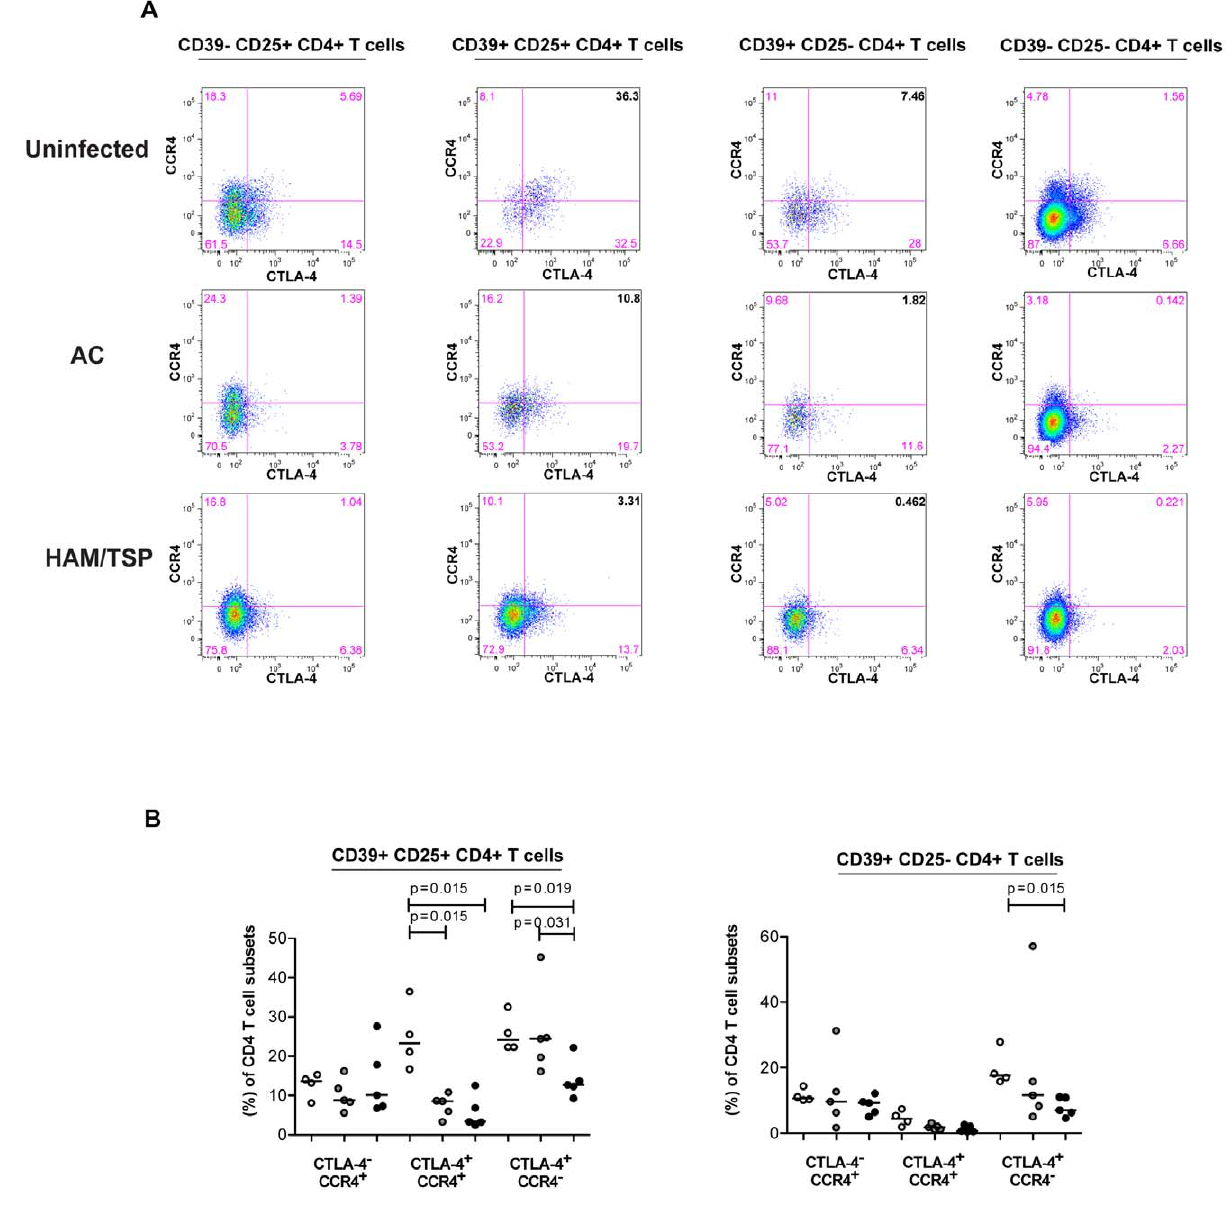
Figure 2. Expression of CTLA-4 and CCR4 in CD4 + T-cell subsets based on CD39 and CD25 expression. The statistical difference was deemed significant using a Mann-Whitney U test analysis if p , 0.05. Horizontal bars denote median values. (A) CTLA-4 and CCR4 expression on CD4 + T cells from one representative uninfected donor, one HTLV-1-infected-asymptomatic carrier and one HAM/TSP patient. (B) Proportion of expression of CTLA-4 and CCR4 in CD39 + CD25 + and CD39 + CD25 2 CD4 + T cells of uninfected donors, AC and HAM/TSP patients.